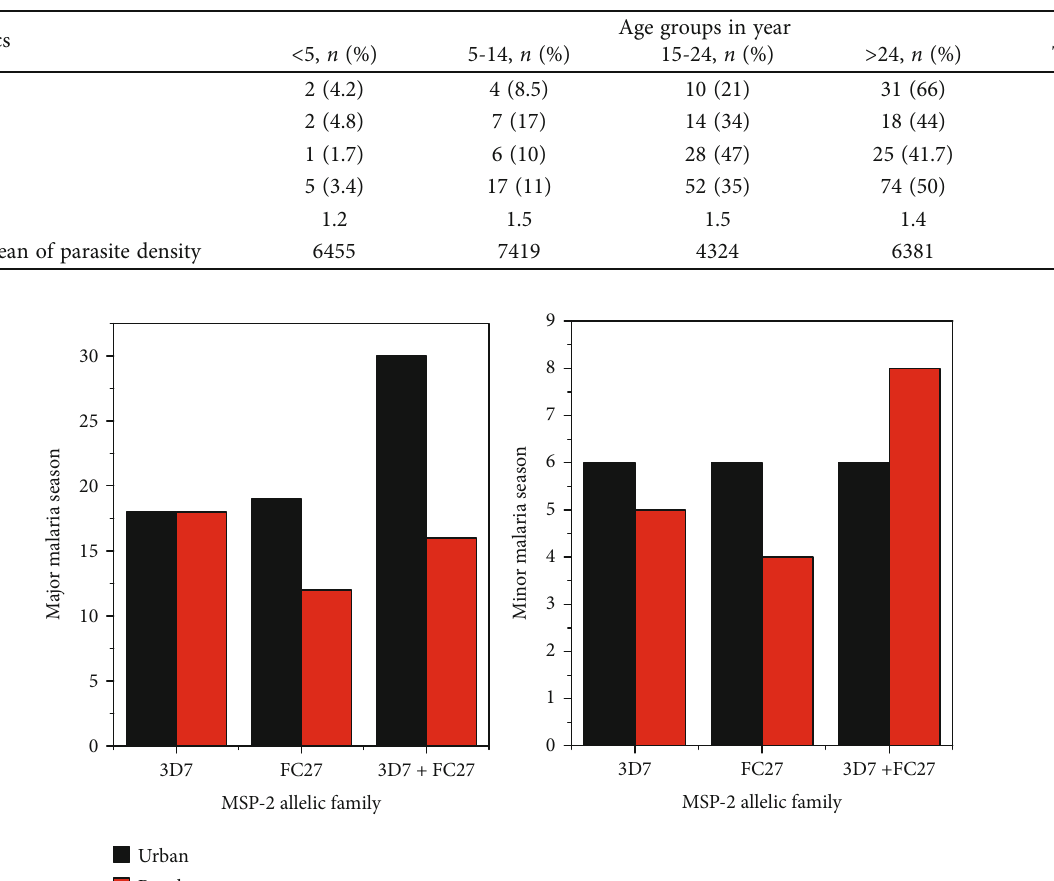
Figure 2: Urban-rural and seasonal features of the msp-2 allelic variant of P. falciparum isolates from September 2019 to August 2020, in the study area ( n = 148 ). Analysis of the P. falciparum msp-2 gene allelic variant in relation to parasitaemia level for patients enrolled in the study has shown an overall increment with clinical prevalence of the parasitaemia level from 500 to 49,000/ μ l of blood (Figure